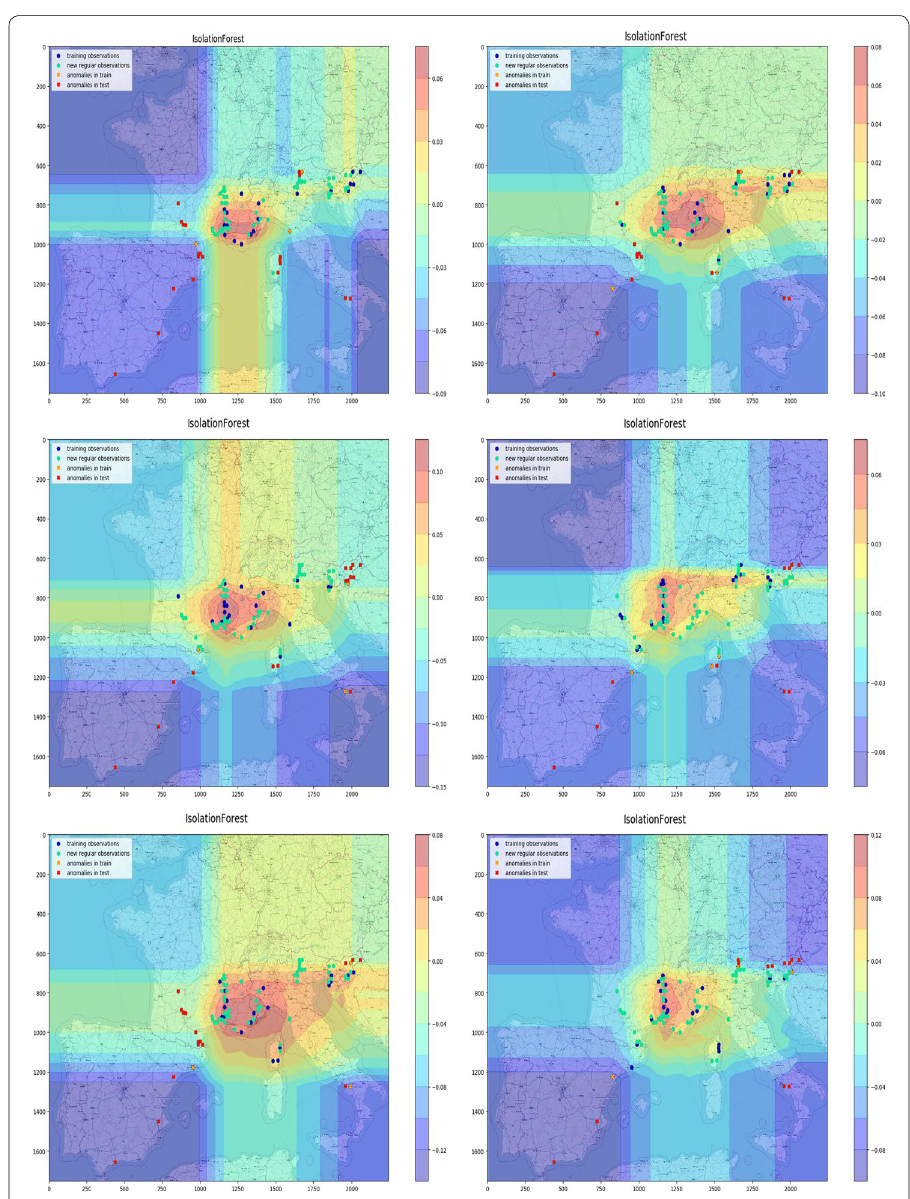
Fig. 1 Some examples of the results of replicates of the execution of IF analysis. The anomalies are reported: those obtained from the training set as yellow squares and in red those obtained from the test